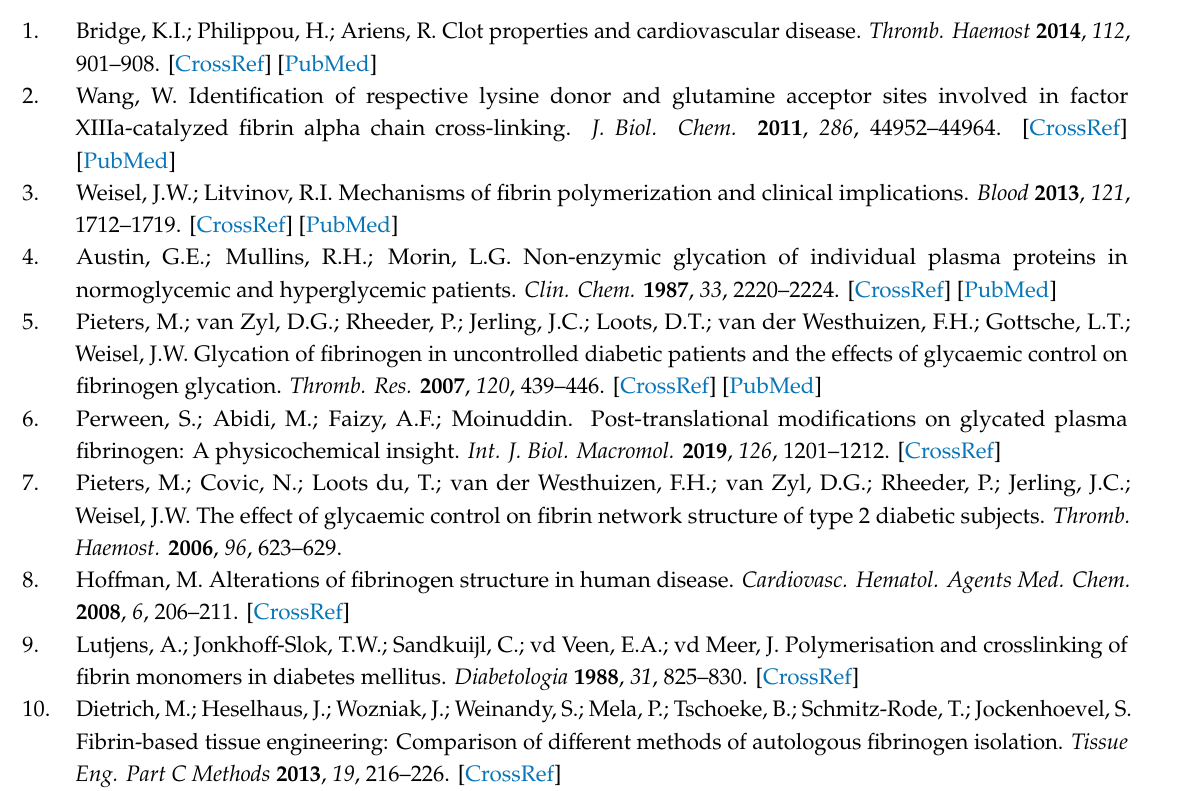
Figure S1: SDS-PAGE and Western blot analysis of human fibrinogen isolated from plasma of diabetic patients and control subjects. Table S1: Clot retraction in plasma samples during in vitro incubation with